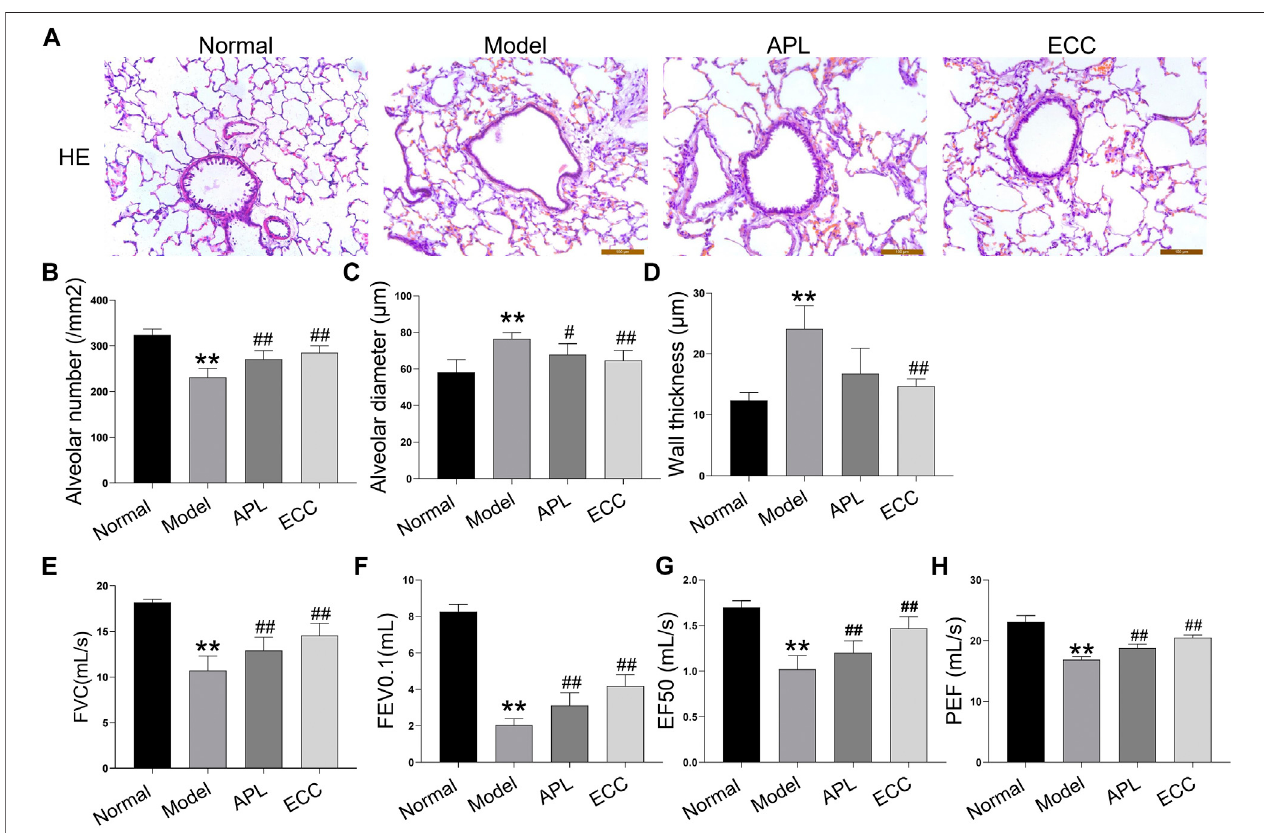
FIGURE 6 | Effects of ECC on pathological changes and lung functioning in rats with COPD. COPD rats were treated with ECC (5.5 mg/ kg) and aminophylline (APL; 54 mg/ kg) for 8 weeks (weeks 12 – 20). (A) H&E staining (magni fi cation, × 100), (B) alveolar number, (C) alveolar diameter, (D) wall thickness, (E) FVC, (F) FEV at 0.1 s, (G) peak expiratory fl ow,andexpiratory fl owat 50%tidal volume(EF50);and (H) PEFwereassessed at week 20.Alldataarepresentedasthemean ± SEM( n (cid:2) 6 for each group) vs . normal, ** p < 0.01; vs . model, # p < 0.05, ## p <